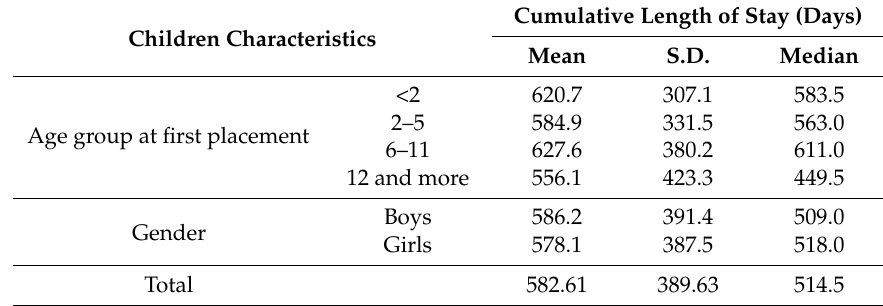
Table 6. Cumulative length of stay among children from cohort Post2 placed at least once in non-kinship care and whose case have been brought to court ( n = 2106).